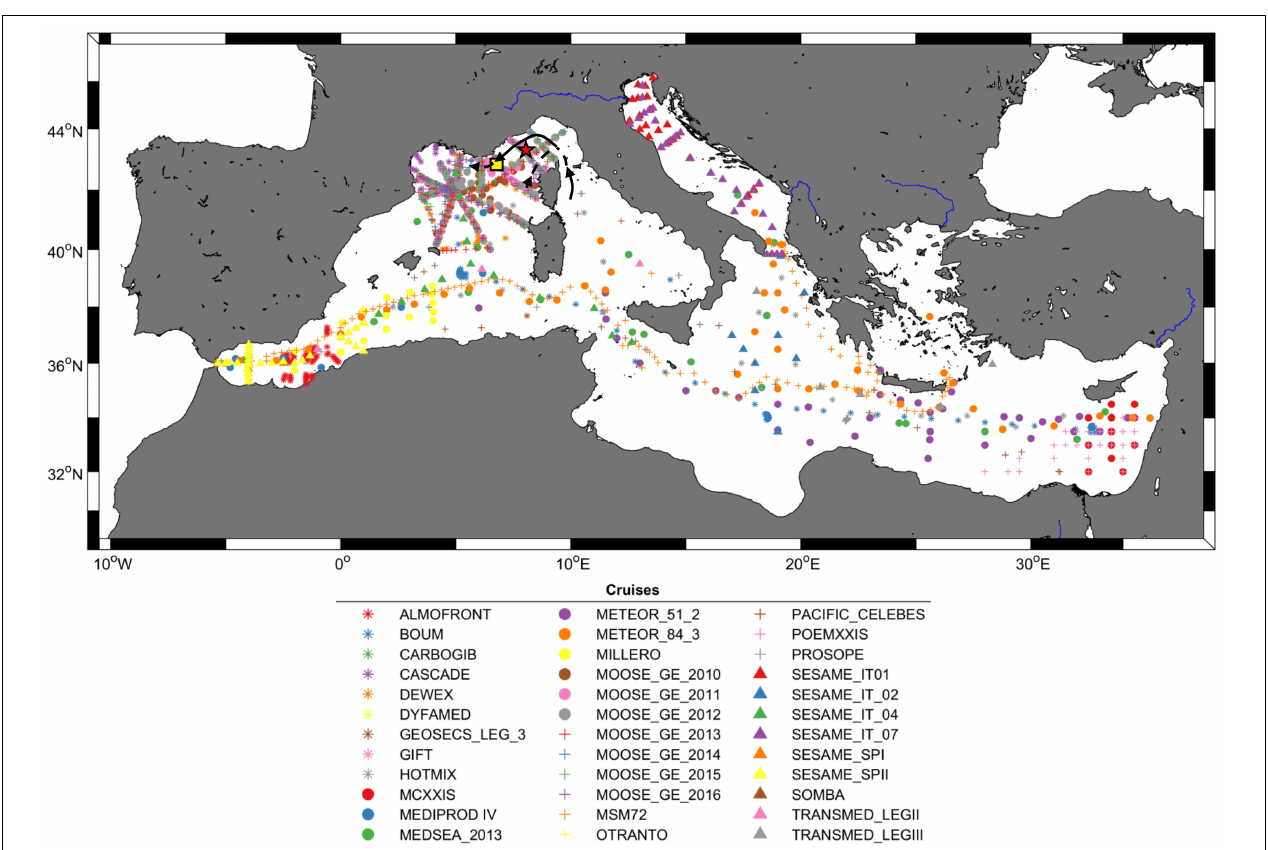
FIGURE 1 | Location of the 35 cruises used in this study, and of the DYFAMED (red star) and ANTARES (yellow square) sites in the Ligurian Sea, Northwestern Mediterranean, with a schematic representation of the North Current circulation in surface (black arrows). The DYFAMED time series and the 35 cruises constitute the training dataset whereas the ANTARES time series is used for